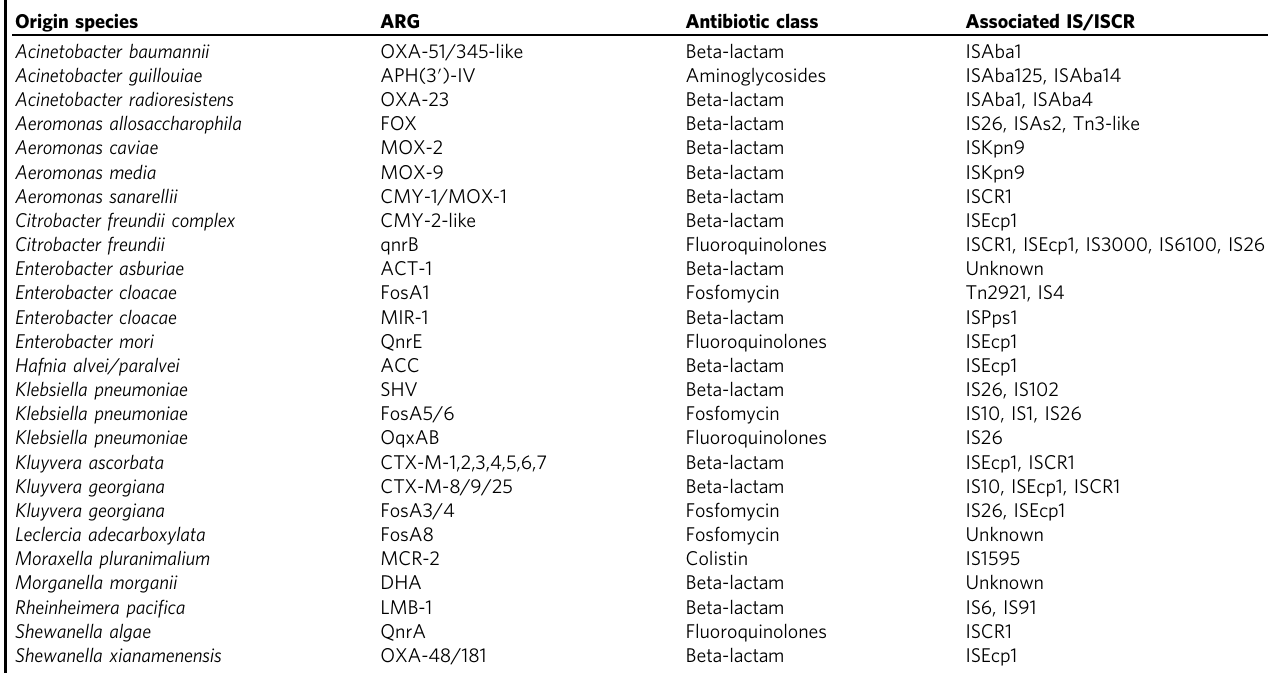
Table 1 The investigated origin species together with the respective mobilized antibiotic resistance gene (ARG) and associated IS/ISCR-element